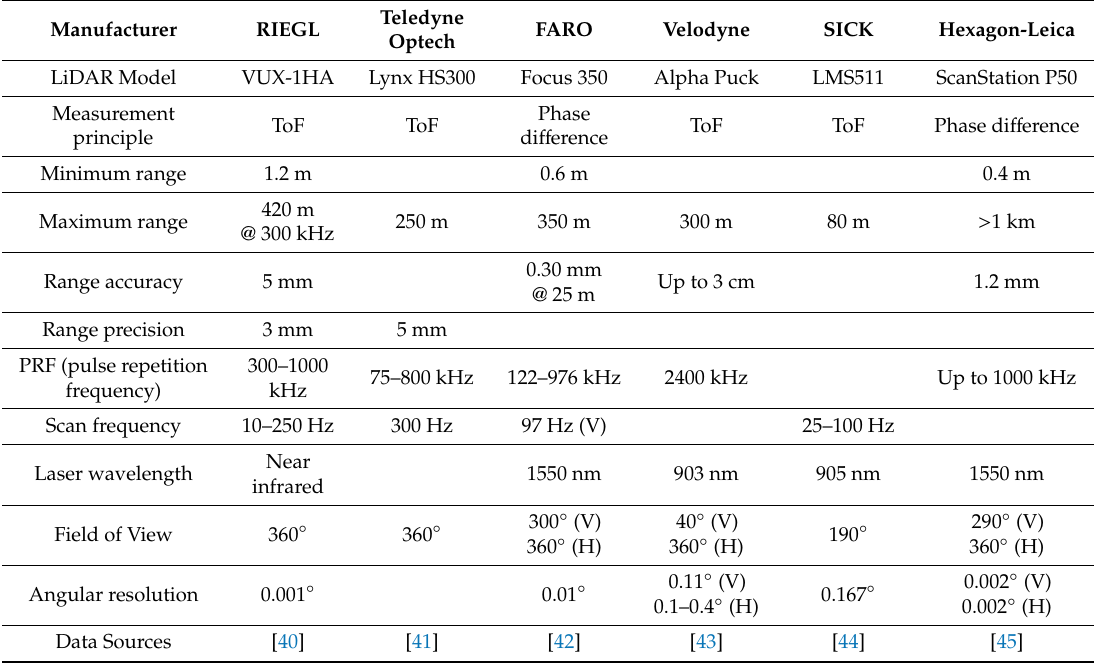
Table 1. Comparison of di ff erent commercial laser